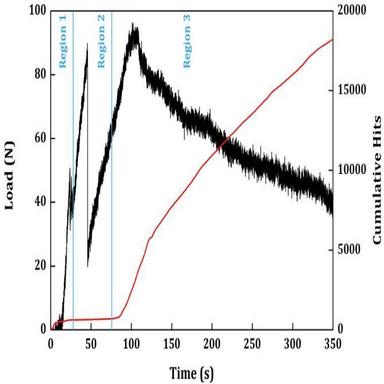
Load-displacement for specimens A, B and C. Fig. 5. Load vs Time and Cumulative Hits vs Time for Specimen A.